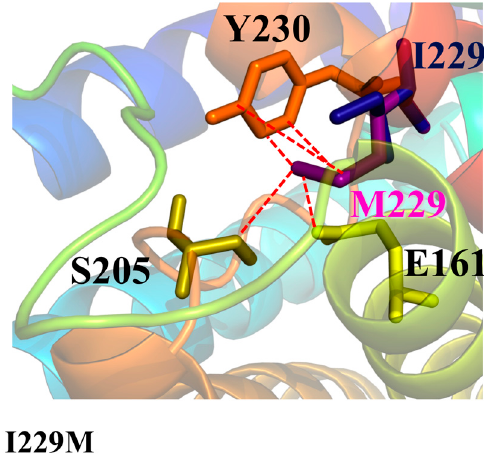
Figure 7. Cartoon representation of human AQP8 and its mutant I229M with discussed residues shown as sticks. Clashes between residues are shown in red dashed lines.